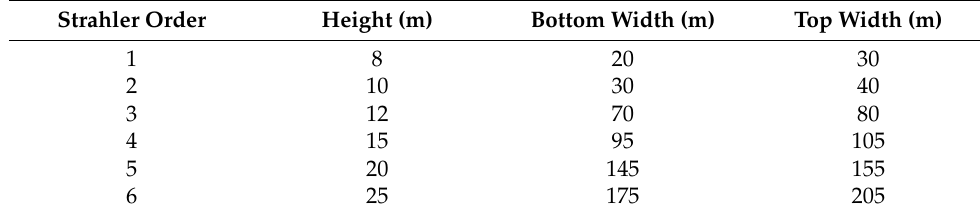
Table 3. River cross-sections